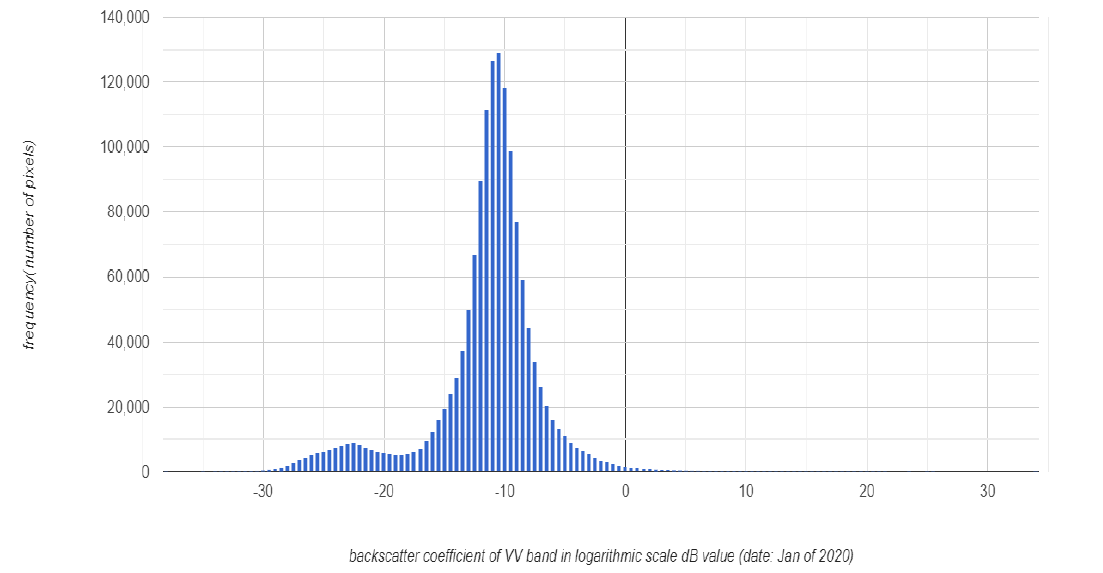
Figure 3. An Example of Histogram of VV Band in dB value (4 January 2020), the x-axis represents that backscatter coefficient is calculated in dB scale, the y-axis represents that how many pixels have the same dB value in a bin and the interval of bins is 0.5.